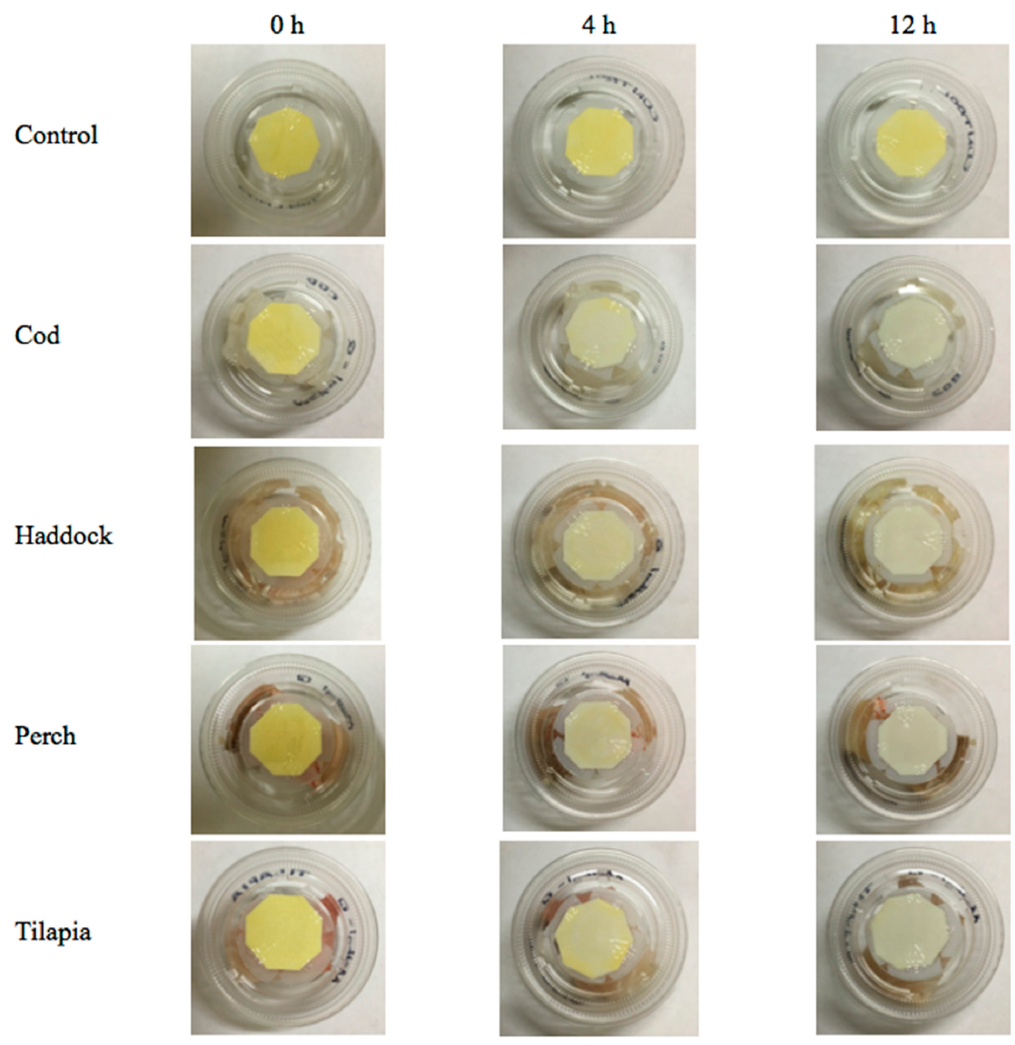
Figure 5. Color response images captured for using acid-doped quinoxaline 5b -loaded cellulose paper